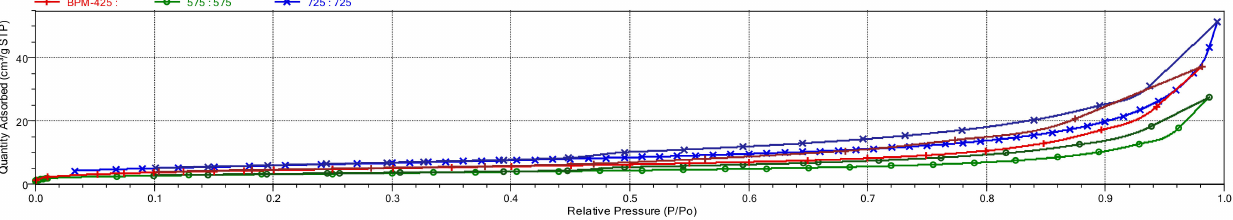
Figure 2. The adsorption–desorption isotherms